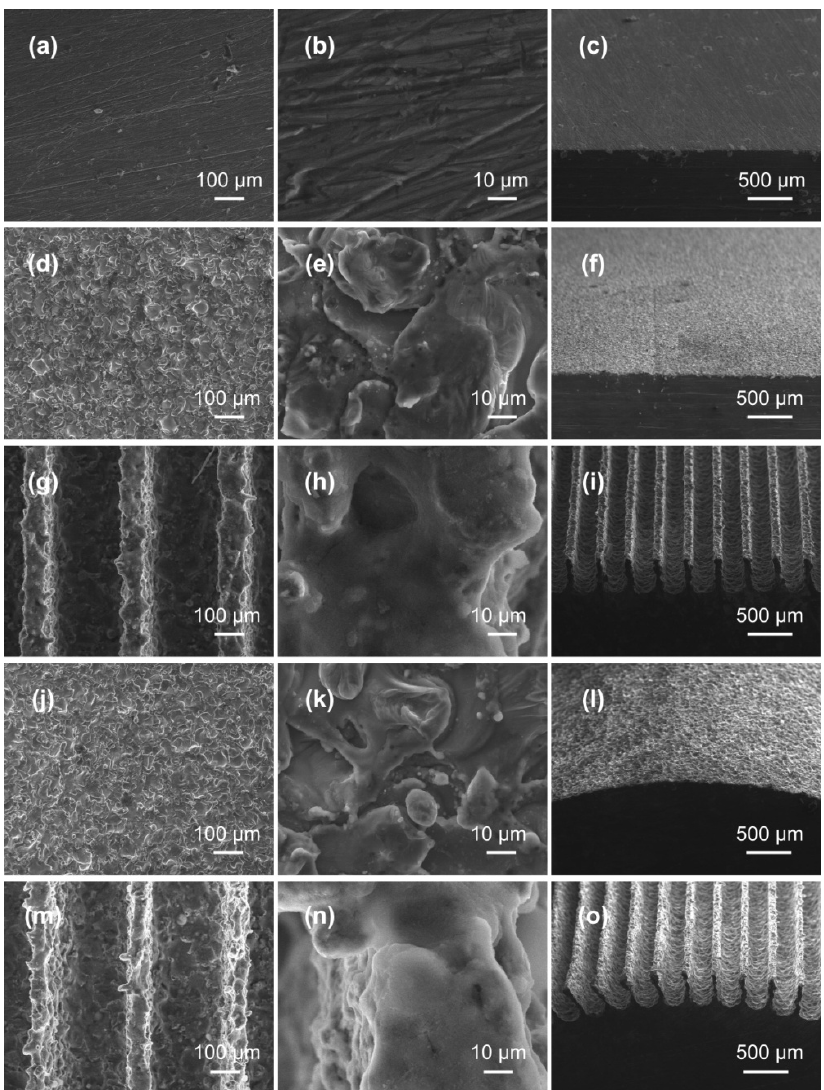
Figure 4. SEM images of different WEDM aluminum alloy surfaces: ( a ), ( b ), and ( c ) Morphology and cross section of polished surface; ( d ), ( e ), and ( f ) the morphology and cross section of plane surface with dual-level structure; ( g ), ( h ), and ( i ) the morphology and cross section of plane surface with three-level structure; ( j ), ( k ), and ( l ) the morphology and cross section of convex surface with dual-level structure; ( m ), ( n ), and ( o ) the morphology and cross section of convex surface with three-level structure.